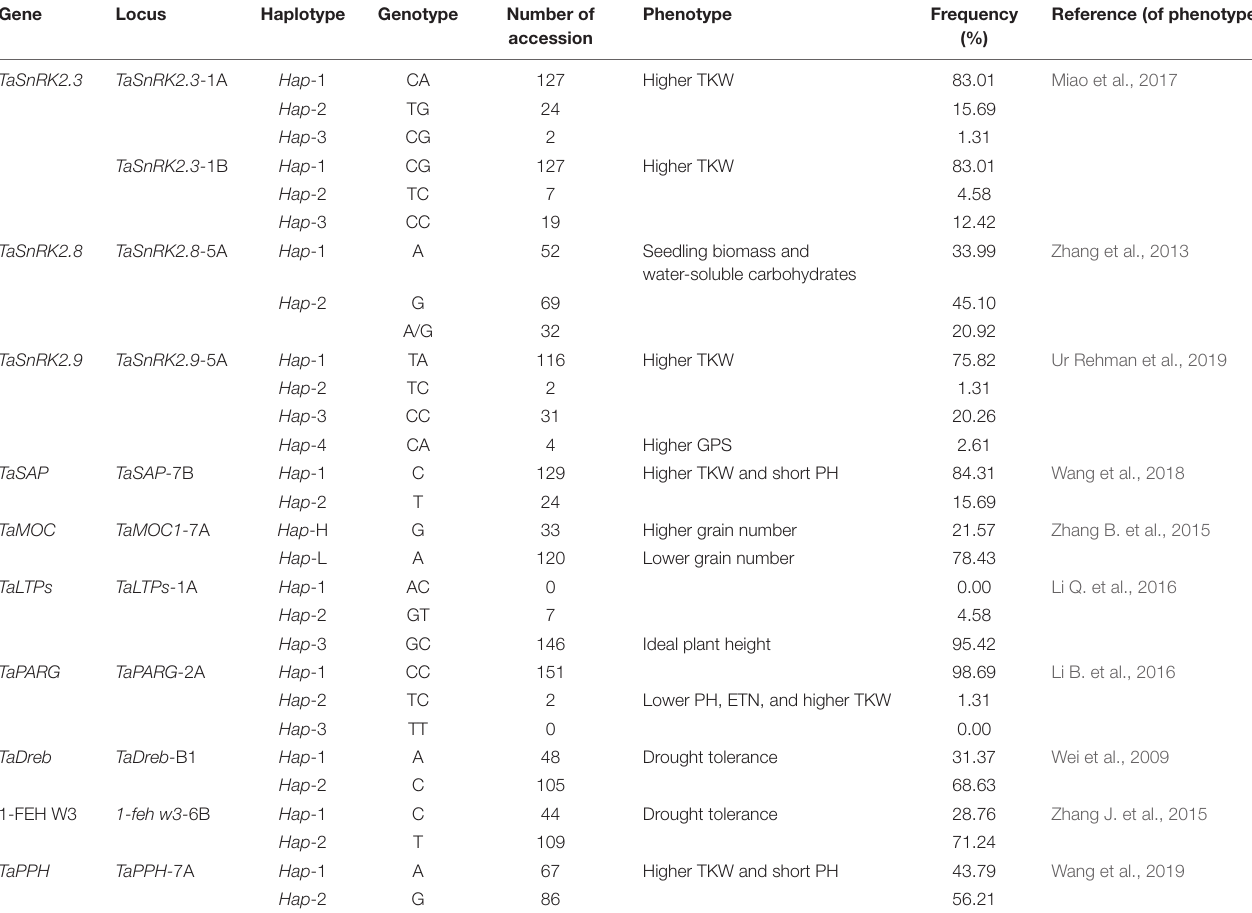
TABLE 1 | Allelic frequencies in 153 Pakistani wheat cultivars. Gene Locus Haplotype Genotype Number of